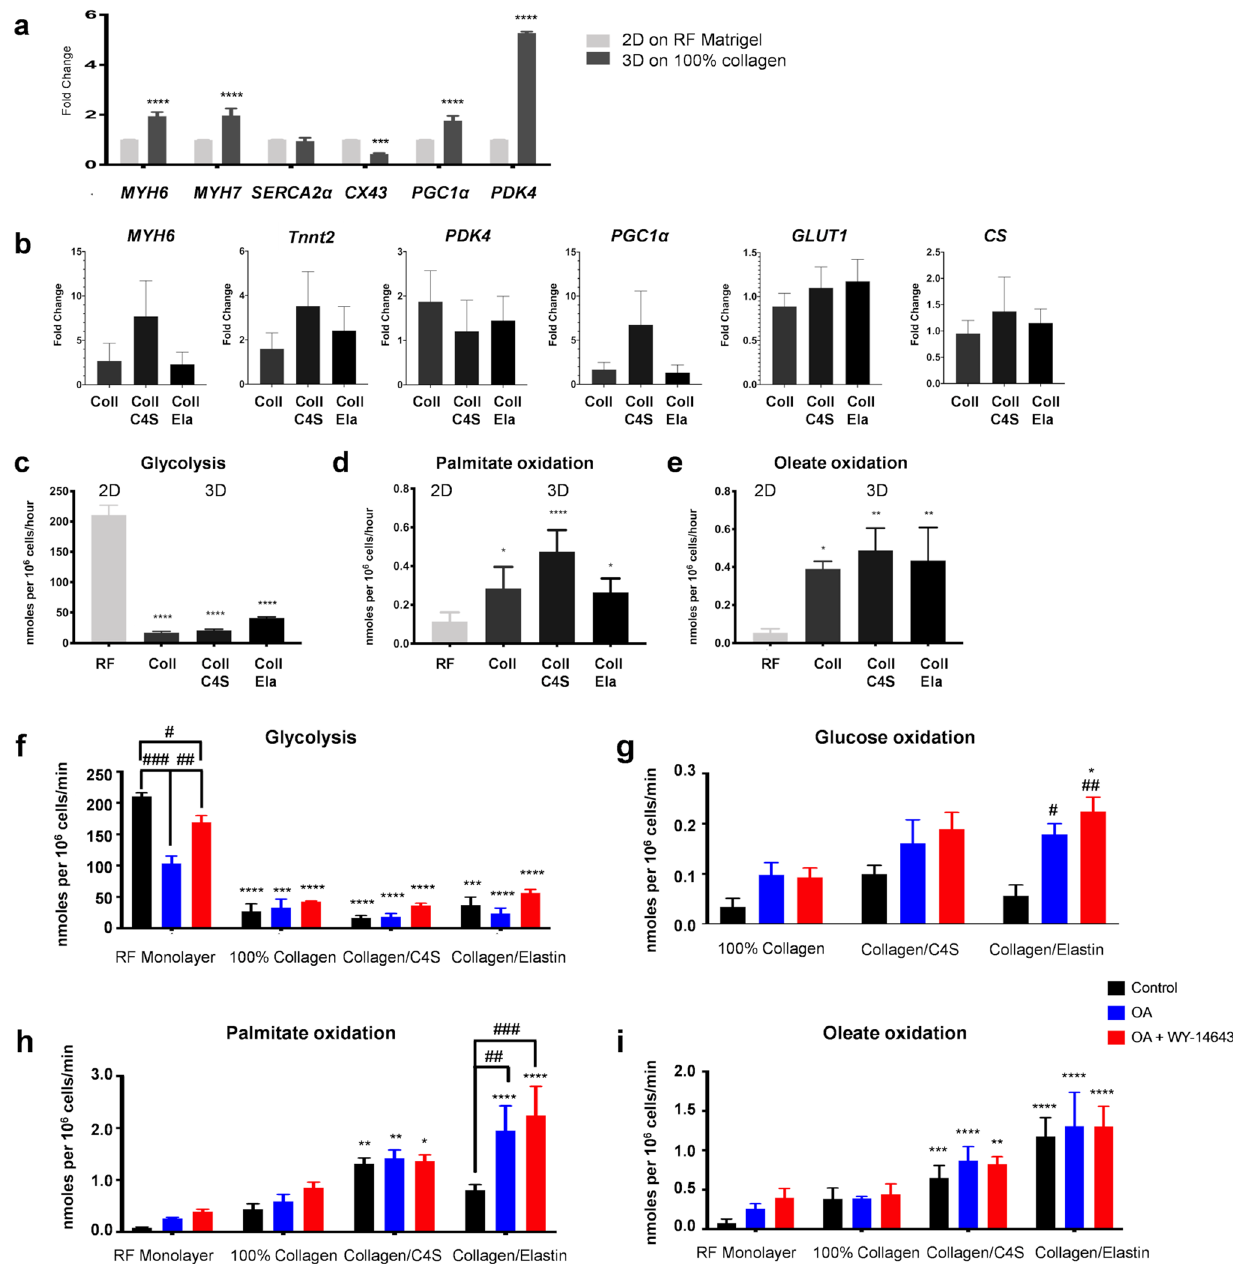
Figure 4. ( a ) Changes in mRNA expression of day 12–15 hiPSC-CMs seeded as a monolayer on RF-Matrigel (RF) or in 3D on scaffolds of 100% collagen 1 (100% Coll) and cultured for 1 week. (n = 3) ( b ) Changes in mRNA expression of day 12–30 hiPSC-CMs seeded on scaffolds of collagen (100% Coll), 1:1 collagen:chondroitin-4-sulphate (Coll/C4S) or 1:1 collagen:elastin (Coll/Ela) and cultured for 1 week (n = 3). Rates of ( c ) glycolysis, and oxidation of ( d ) palmitate and ( e ) oleate by day 12–15 hiPSC-CMs seeded as a monolayer or in 3D on collagen scaffolds and cultured for 1 week in control media. *, **, *** p < 0.5, 0.01, 0.001, respectively compared with hiPSC-CMs on RF-Matrigel. Rates of (f) glycolysis and oxidation of ( g ) glucose, ( h ) palmitate and ( i ) oleate by day 12–15 hiPSC-CMs seeded as a monolayer or in 3D and cultured for 1 week in control media or with addition of OA ± WY-14643. *, **, *** p < 0.5, 0.01, 0.001, respectively compared with hiPSC-CMs on RF-Matrigel; #, ##, ###, #### p < 0.5, 0.01, 0.001, 0.001, respectively compared to the control in their respective group (n =